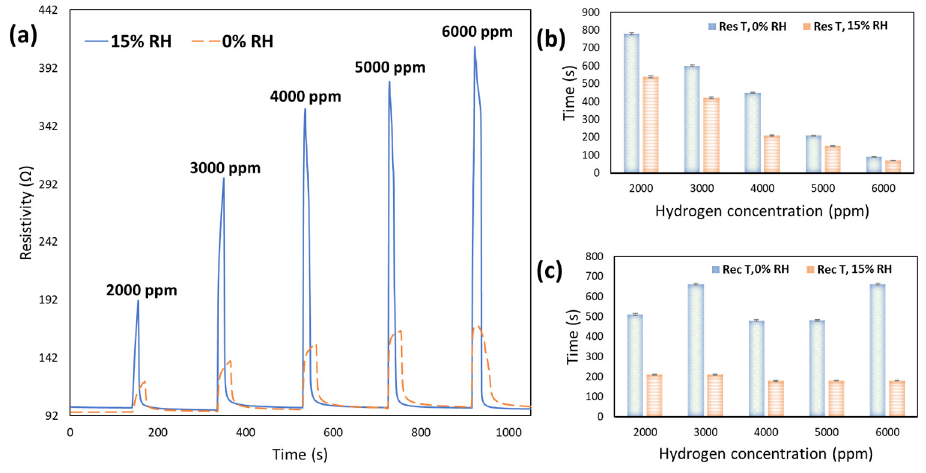
Figure 9. ( a ) The UV excited dynamic responses of CeO 2 -Pd-PDA/rGO sensor at 100 °C and various H 2 concentrations (2000–6000 ppm) in dry ambient conditions and under 15% relative humidity; ( b ) response times of the sensor at 0 and 15% RH as a function of H 2 concentration; ( c ) recovery times of the sensor at 0 and 15% RH and different H 2 concentrations.